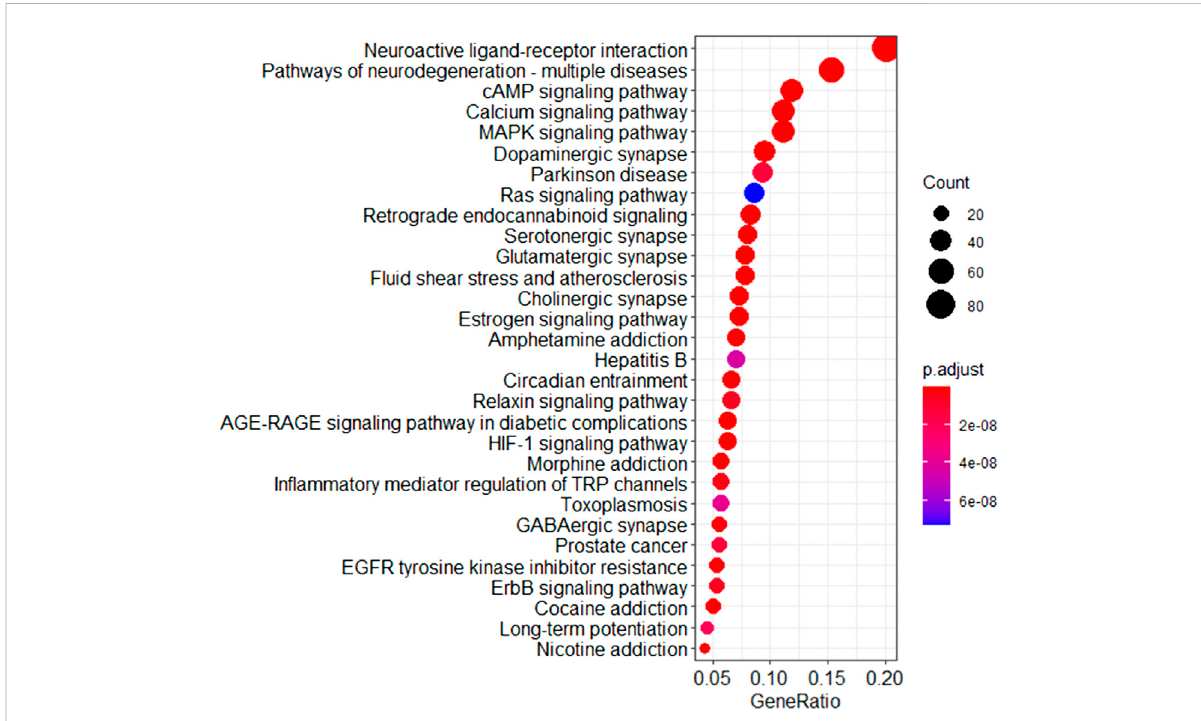
FIGURE 7 Pathway enrichment analysis of the targets of FCG in DSS. FCG, functional components group; DSS,